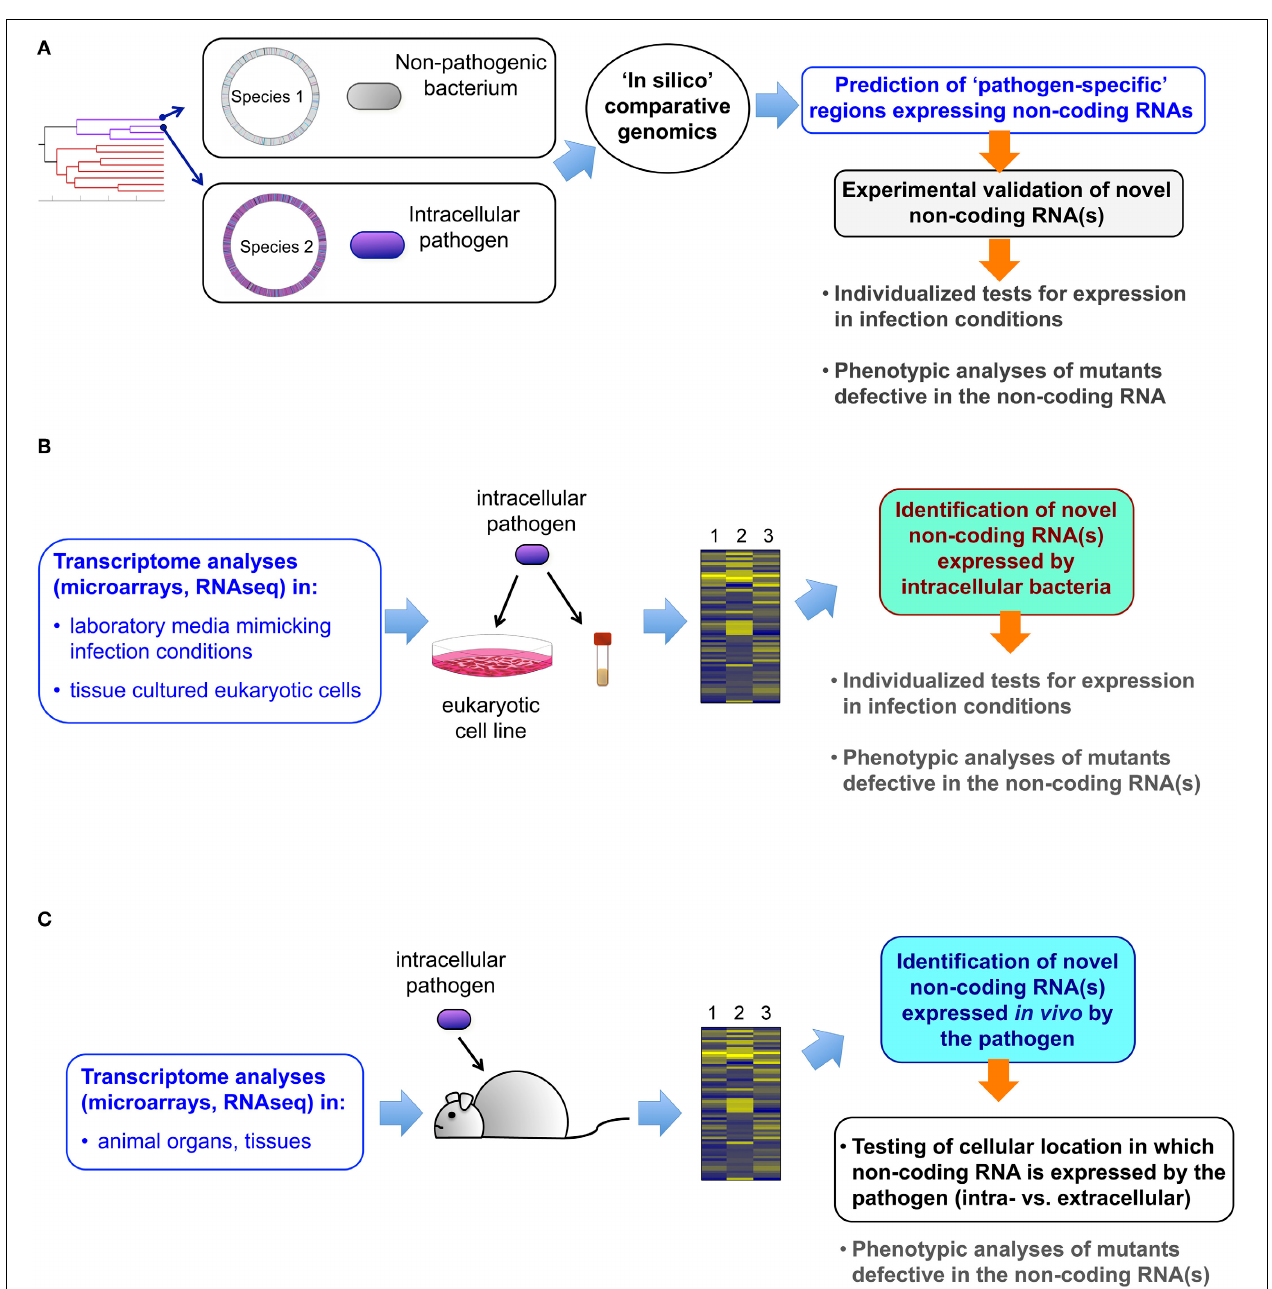
FIGURE 1 | Approaches leading to the identification of novel non-coding RNAs in intracellular bacterial pathogens. (A) Comparative genomics of two closely and phylogenetically-related bacterial species, one pathogenic, and the other not, allows the identification of pathogen-specific genome regions predicted to generate non-coding RNA. These candidates can be further validated experimentally and tested for putative function in virulence with the corresponding defective mutants constructed ad-hoc ; (B) analyses of transcriptomic data obtained with classical microarray technology or, alternatively by RNA-seq, allow the identification of non-coding RNAs in (i) the pathogen when growing in laboratory media mimicking infection conditions;